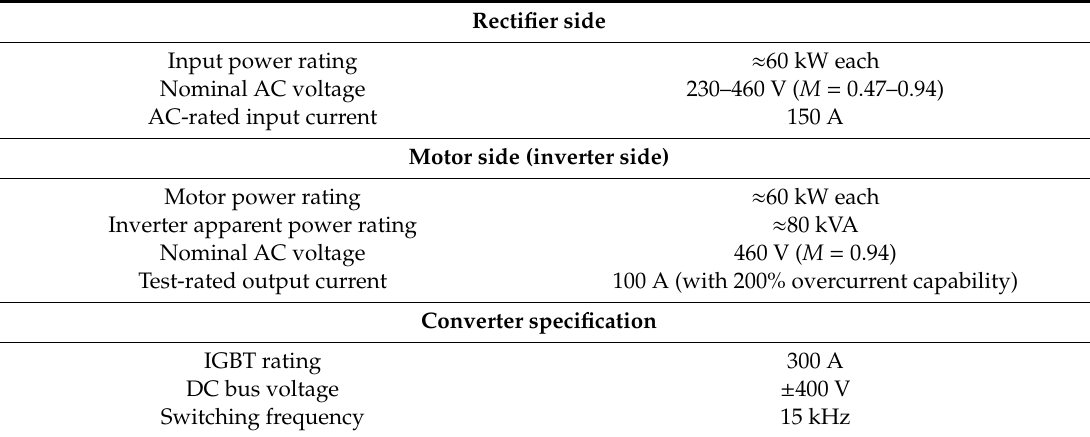
Table 2. Specifications of converters for motor